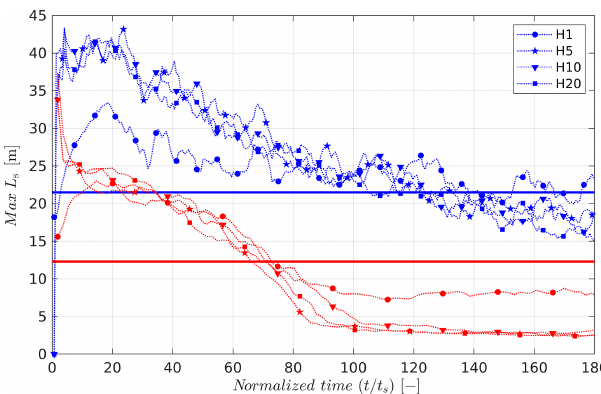
Figure 12. Identification of MSL for the different Hα cases. Lines are coloured to represent the high-wind (UH, blue) and medium- wind (UM, red) scenarios. Corresponding values of MSL identified in Sect. 3 and in Fig. 8 are shown as thick solid lines for reference.